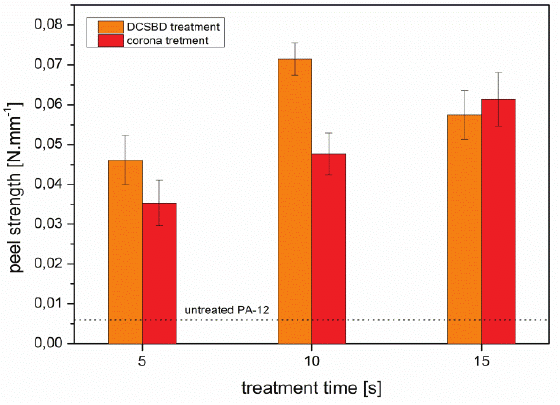
Figure 4: Peel strength of PA-12 modified by DCSBD and industrial